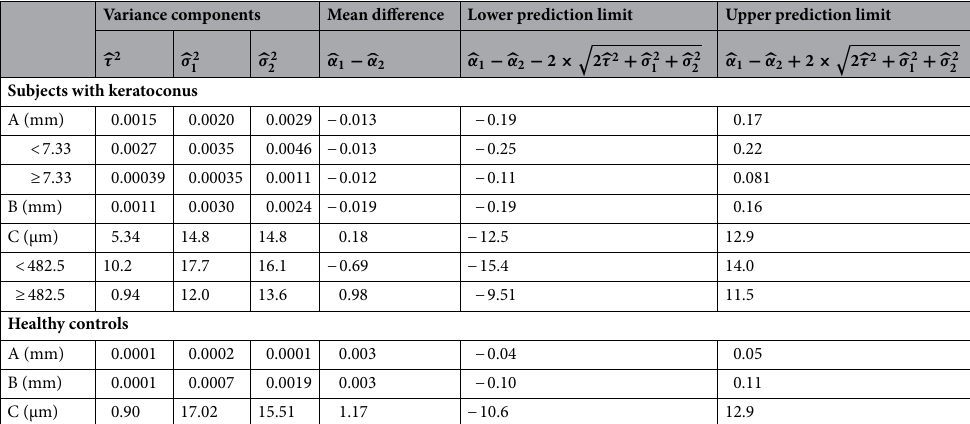
Table 4. Inter-day differences between single measurements of the parameters A, B and C with prediction limits for subjects with keratoconus and healthy controls (single measurements). A = Anterior curvature of the 3 mm zone over the thinnest point (mm). B = Posterior curvature of the 3 mm zone under the thinnest point 2 (mm). C = Thickness at the thinnest point on the cornea (μm). (cid:31) τ = squared between-subject mean variance 2 (cid:31) σ 2 between Day 0 and Day 3; (cid:31) σ 1 = squared within-subject mean variance on Day 0; 2 = squared within-subject mean variance on Day 3; (cid:31) α 1 − (cid:31) α 2 = difference between means on Day 0 and Day